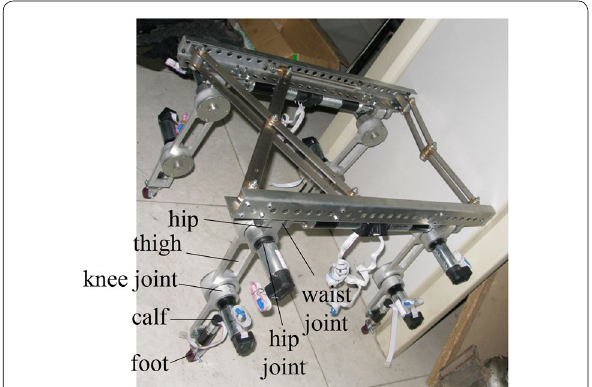
Figure 1 Configuration of the exoskeleton arm system